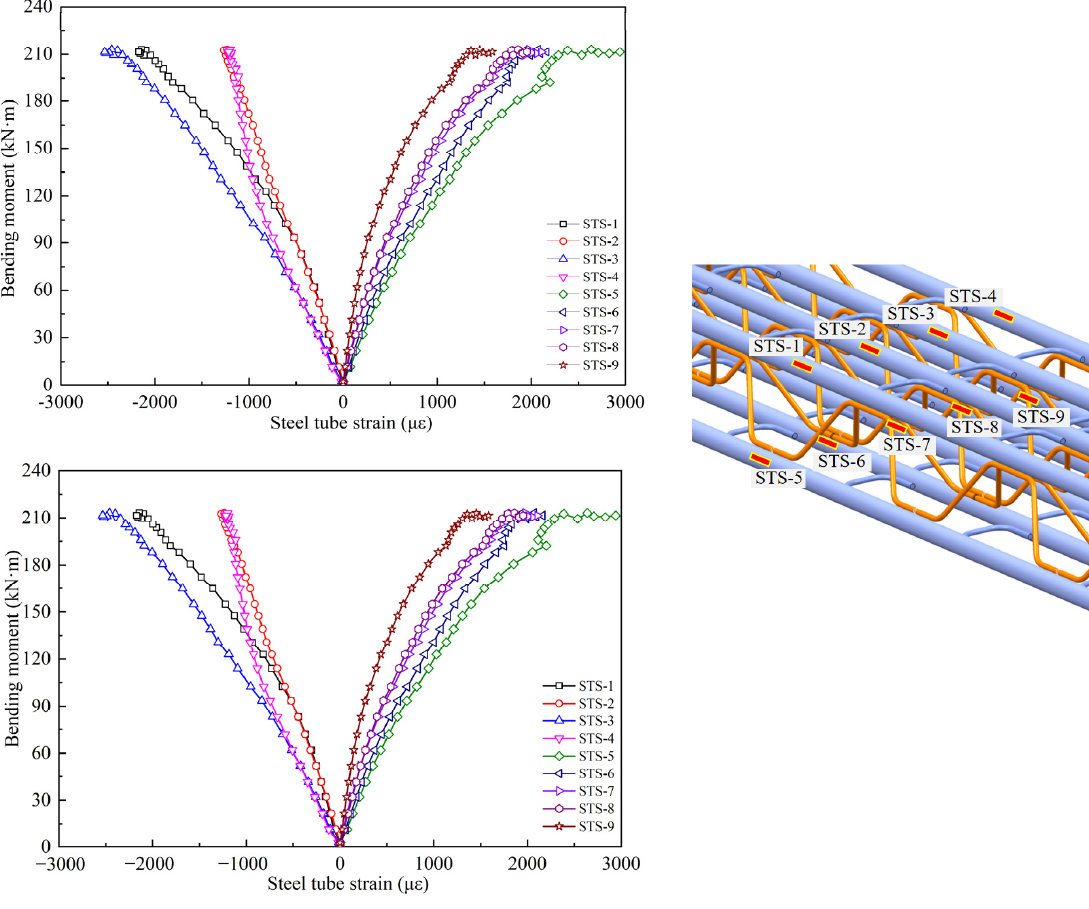
Figure 17. Bending moment–steel tube strain relationship curves of the 1/8 section of the jointless component.